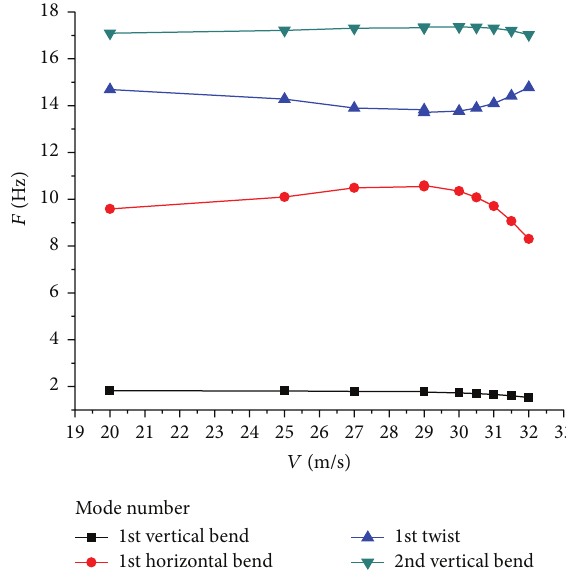
Figure 16: Structural frequency under nonlinear static deflections.